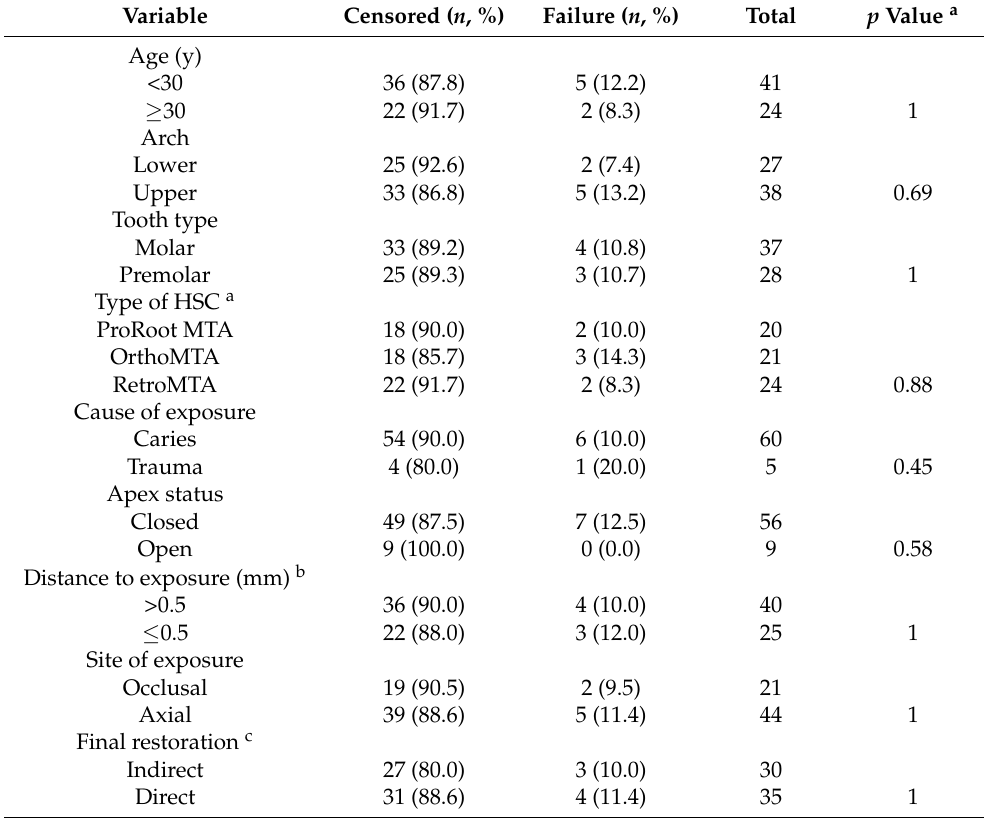
Table 2. Descriptive statistics of partial pulpotomy with hydraulic silicate cements (HSCs) in long- term (48–78 months) follow-up group ( n =